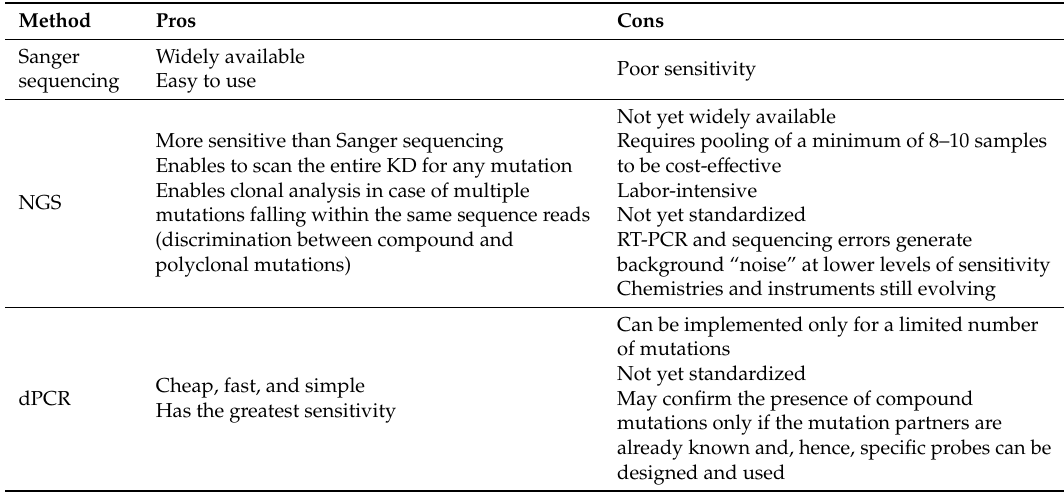
Table 2. Summary of the main advantages and disadvantages of old (Sanger sequencing) versus novel (NGS and dPCR) technologies for BCR-ABL1 KD mutation